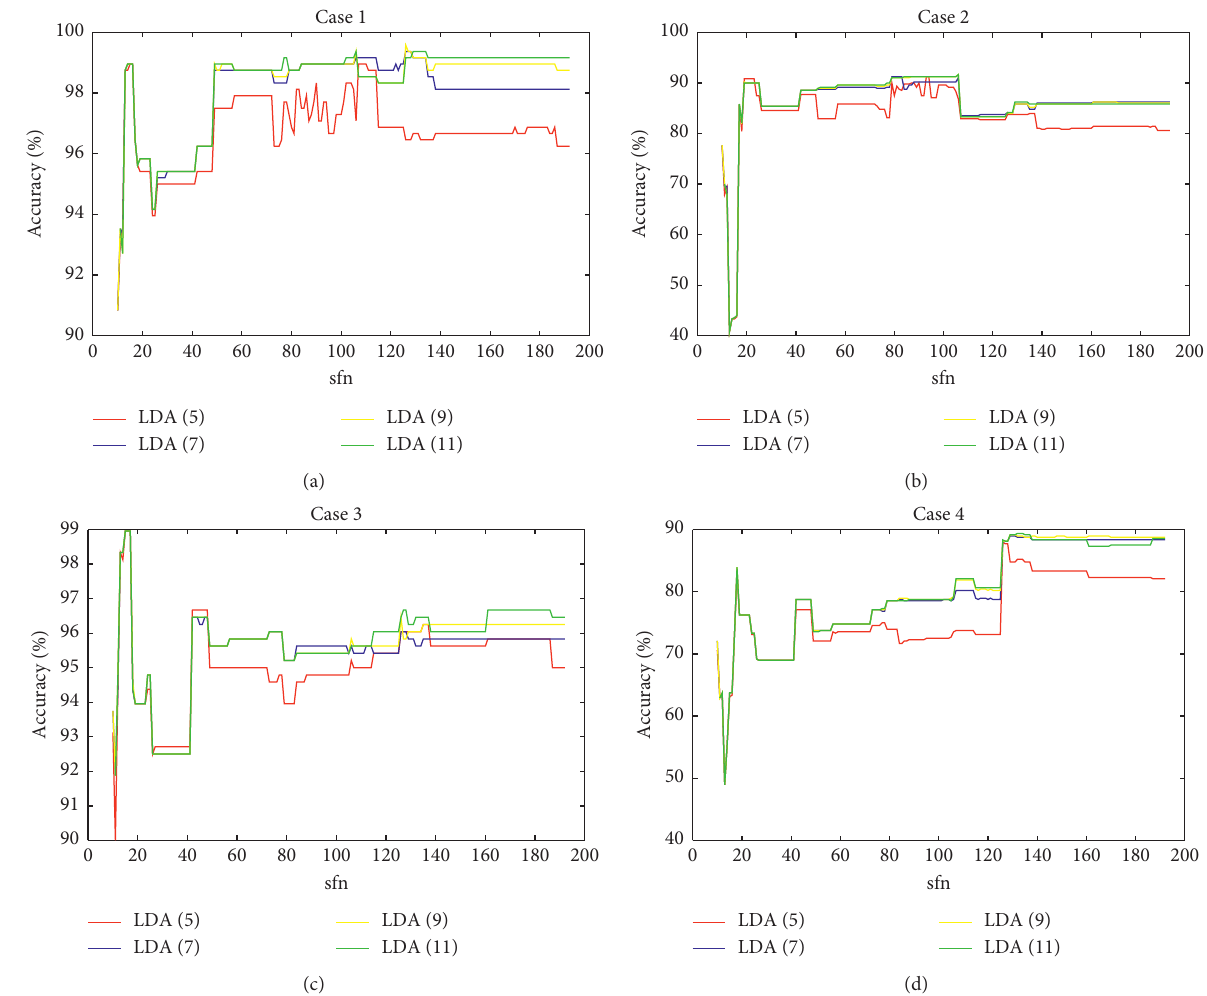
Figure 10: The curve representation of diagnosis results obtained by OFS-TSFRS-LDA-SVM using DTCWPTwith different dimension sizes for LDA. The LDA (5) represents that the number of dimension size is